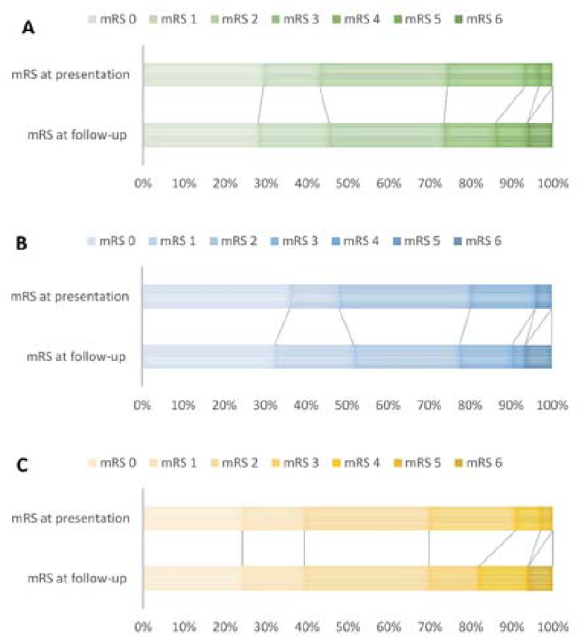
Figure 2. Distribution of the proportions of modified Rankin Scales (mRS) for: ( A ) complete group (missing n = 6 at presentation); ( B ) with childhood onset (missing n = 6 at presentation); ( C ) with adult